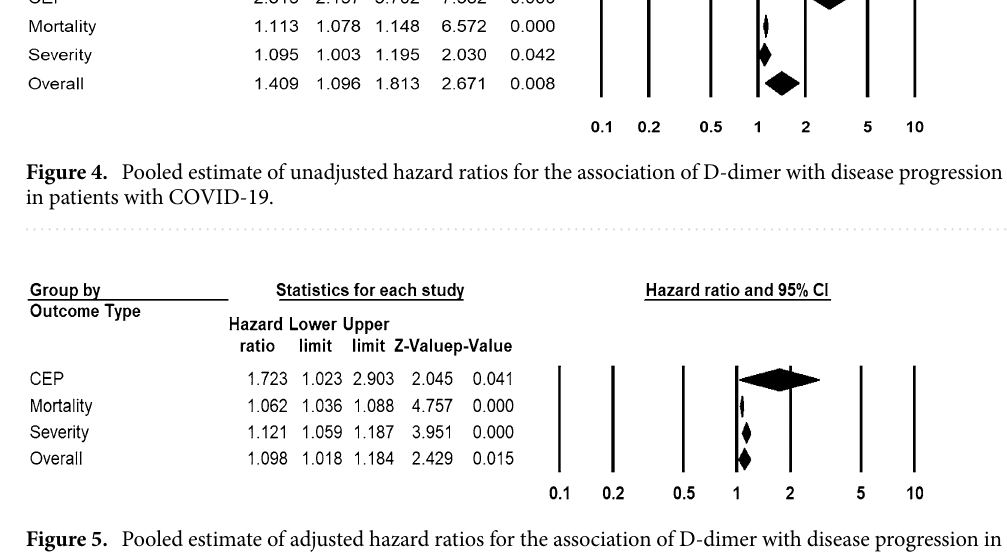
Figure 5. Pooled estimate of adjusted hazard ratios for the association of D-dimer with disease progression in patients with